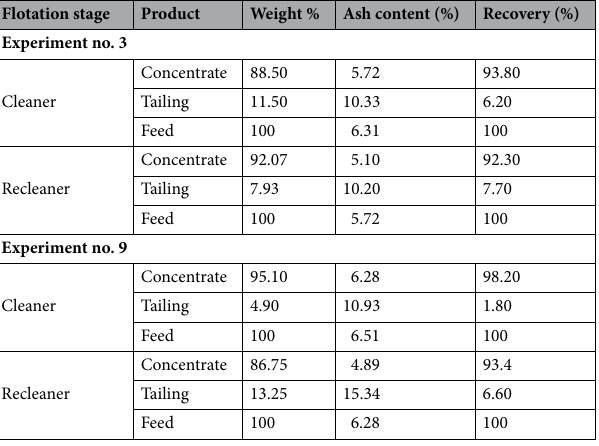
Table 6. Grade and recovery values of flotation in the cleaner and recleaner stages for concentrates of experiments No. 3 and 9.